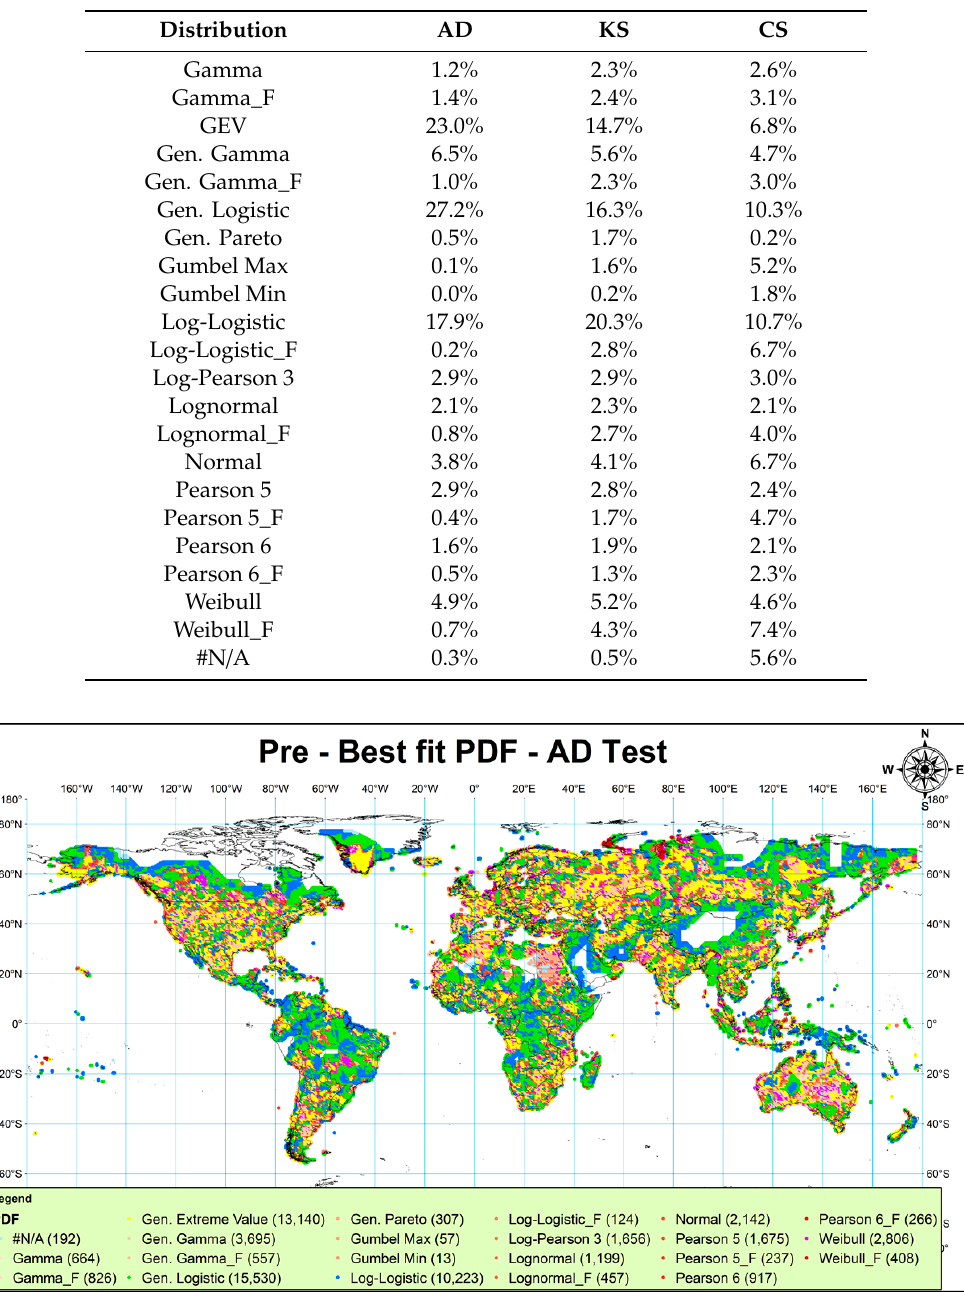
Table 2. Percentage distribution of best-fit probability distribution with di ff erent tests.